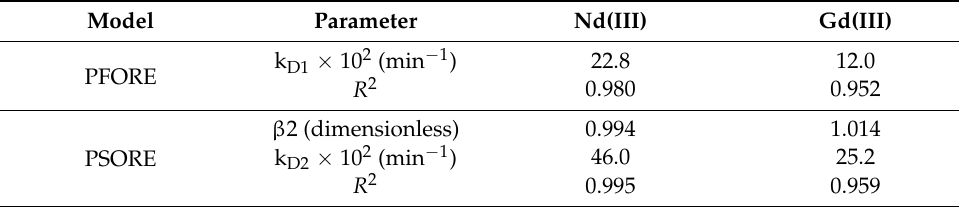
Figure 10. Desorption kinetics for Nd(III) and Gd(III) loaded on mesoporous composite func- tionalized sorbent—modeling with ( a ) the pseudo-first-order rate equation (PFORE) and ( b ) the pseudo-second-order rate equation (PSORE) applied to desorption profiles (loaded samples obtained from uptake kinetic experiments; eluent: 0.5 M HCl solution; SD: 1.25 g L − 1 ; agitation speed: 170 rpm; T: 22 ± 2 ◦ C). Table 3. Kinetics of desorption for Nd(III) and Gd(III)—parameters for